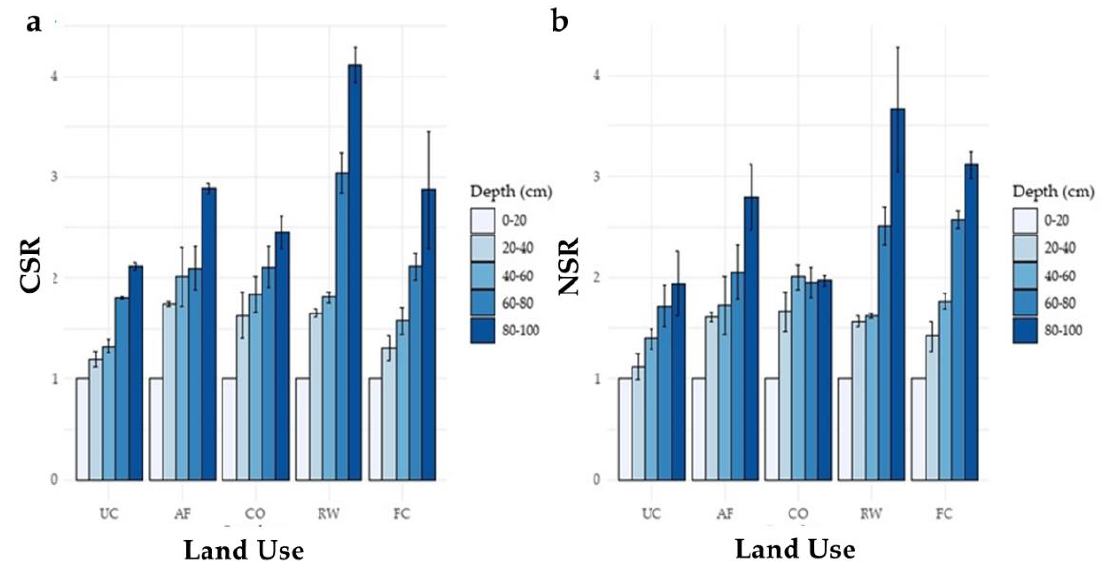
Figure 6. ( a ) Carbon stratification ratio (CSR) and ( b ) nitrogen stratification ratio (NSR) at different soil depths in different land use systems. UC, uncultivated; AF, agroforestry; CO, citrus orchard; RW, rice – wheat system; FC, forage crop. Table 8. Principal component (PC) study of soil organic carbon and nitrogen pools in a hot, arid environment under various land use